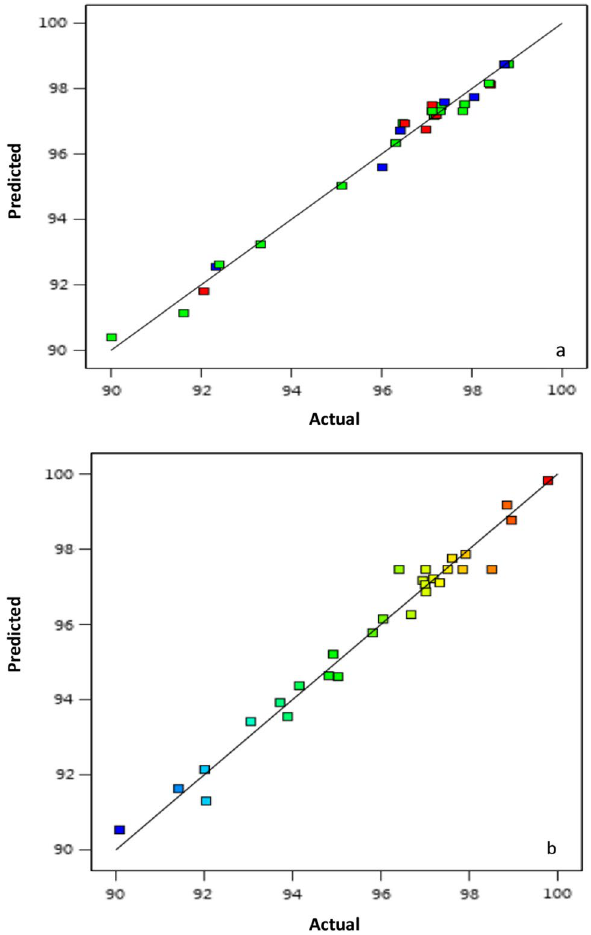
Figure 11. Linear correlation between experimental and predicted removal efficiency % MG by ( a ) nano bentonite and ( b ) MgO impregnated